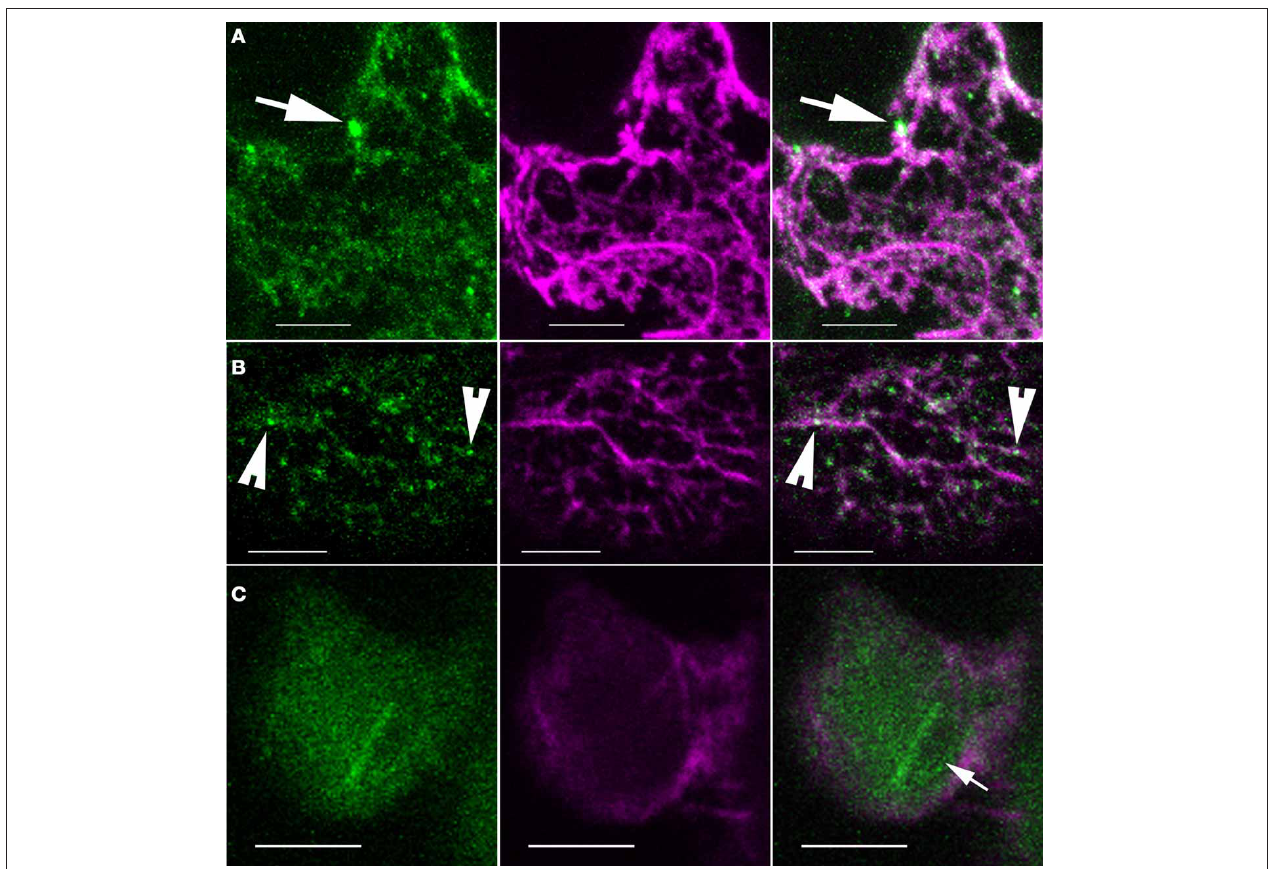
FIGURE 7 | ARP2/3 localization patterns are not obviously altered in sra1 pavement cells. (A–C) Single channel and image overlay projections of confocal images of ARP2/3 (green) and actin (magenta) signals. (A) ARP2/3 punctae of differing size classes are detected adjacent to actin-positive structures as indicated by the arrows.